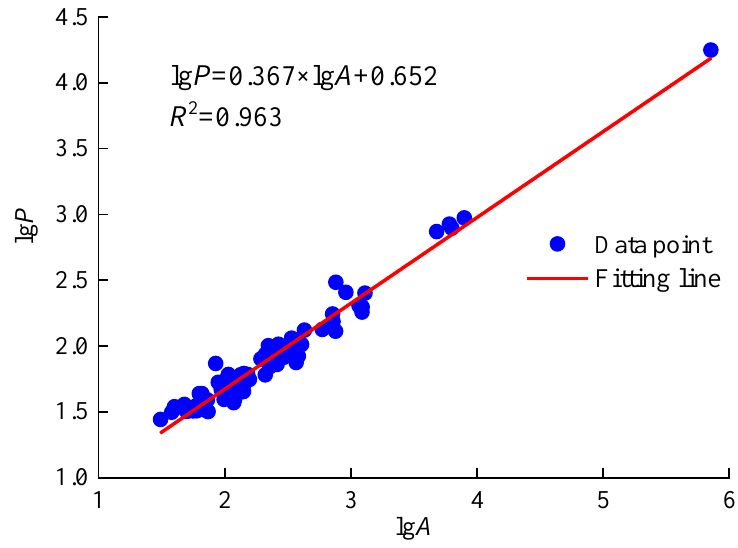
Figure 9. The trend line lg P – lg A.